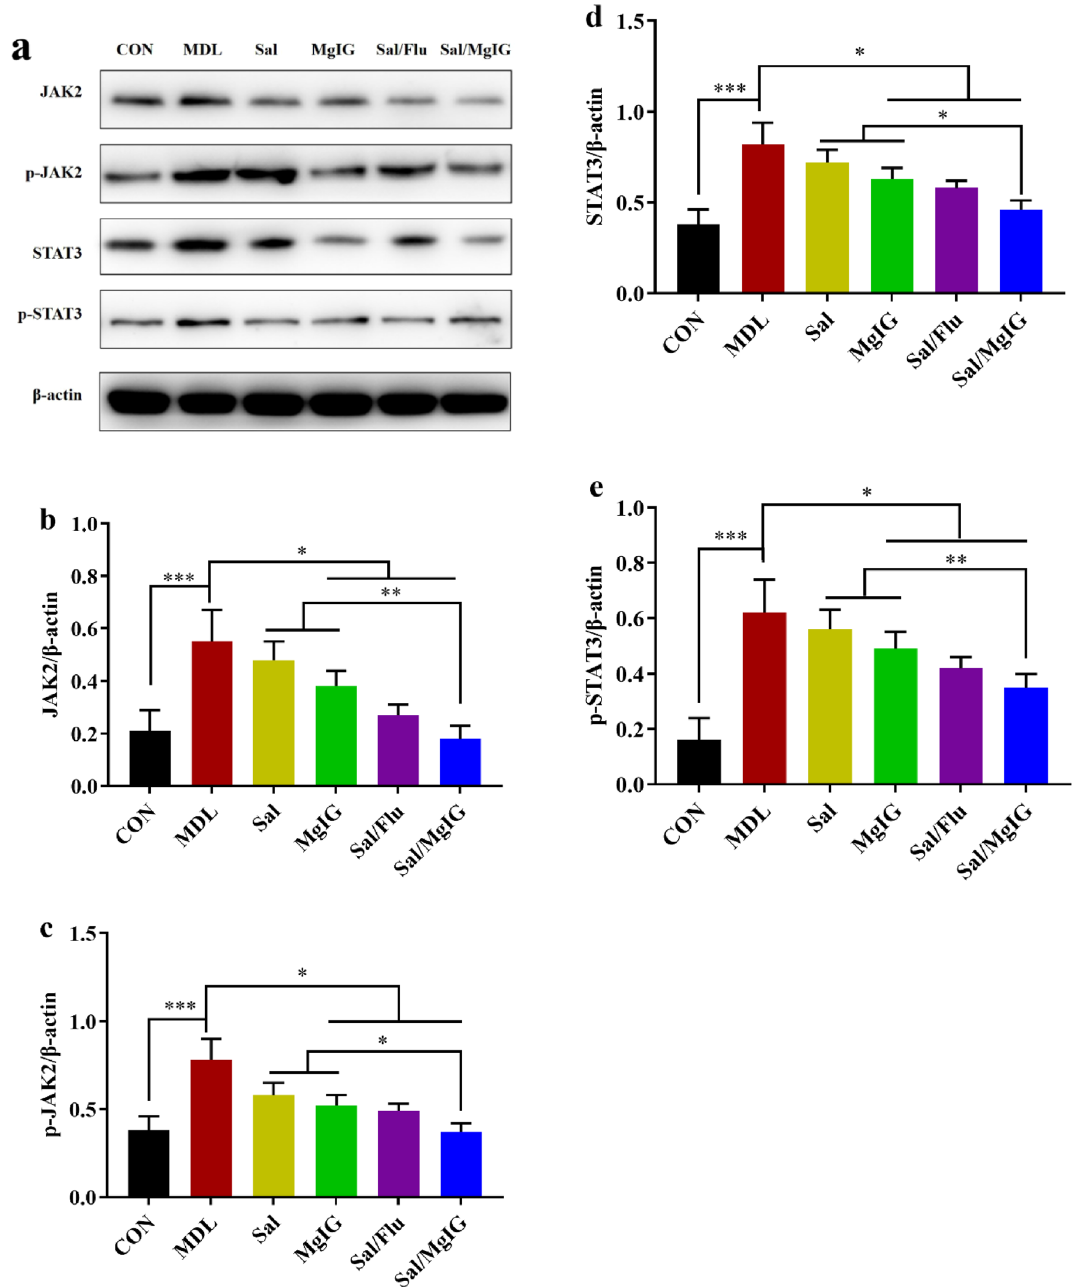
levels of JAK2, p-JAK2, STAT3 and p-STAT3 were detected by western blotting, and the ratio of JAK2/β-actin. ( b–e ), JAK2/β-actin, p-JAK2/β-actin, STAT3/β-actin and p-STAT3/β-actin were shown. All data were presented as mean ± standard deviation (n = 10 in each group). Statistical significance of differences were determined by one-way ANOVA. ***p < 0.001, **p < 0.01 and *p < 0.05 was considered to indicate a statistically significant